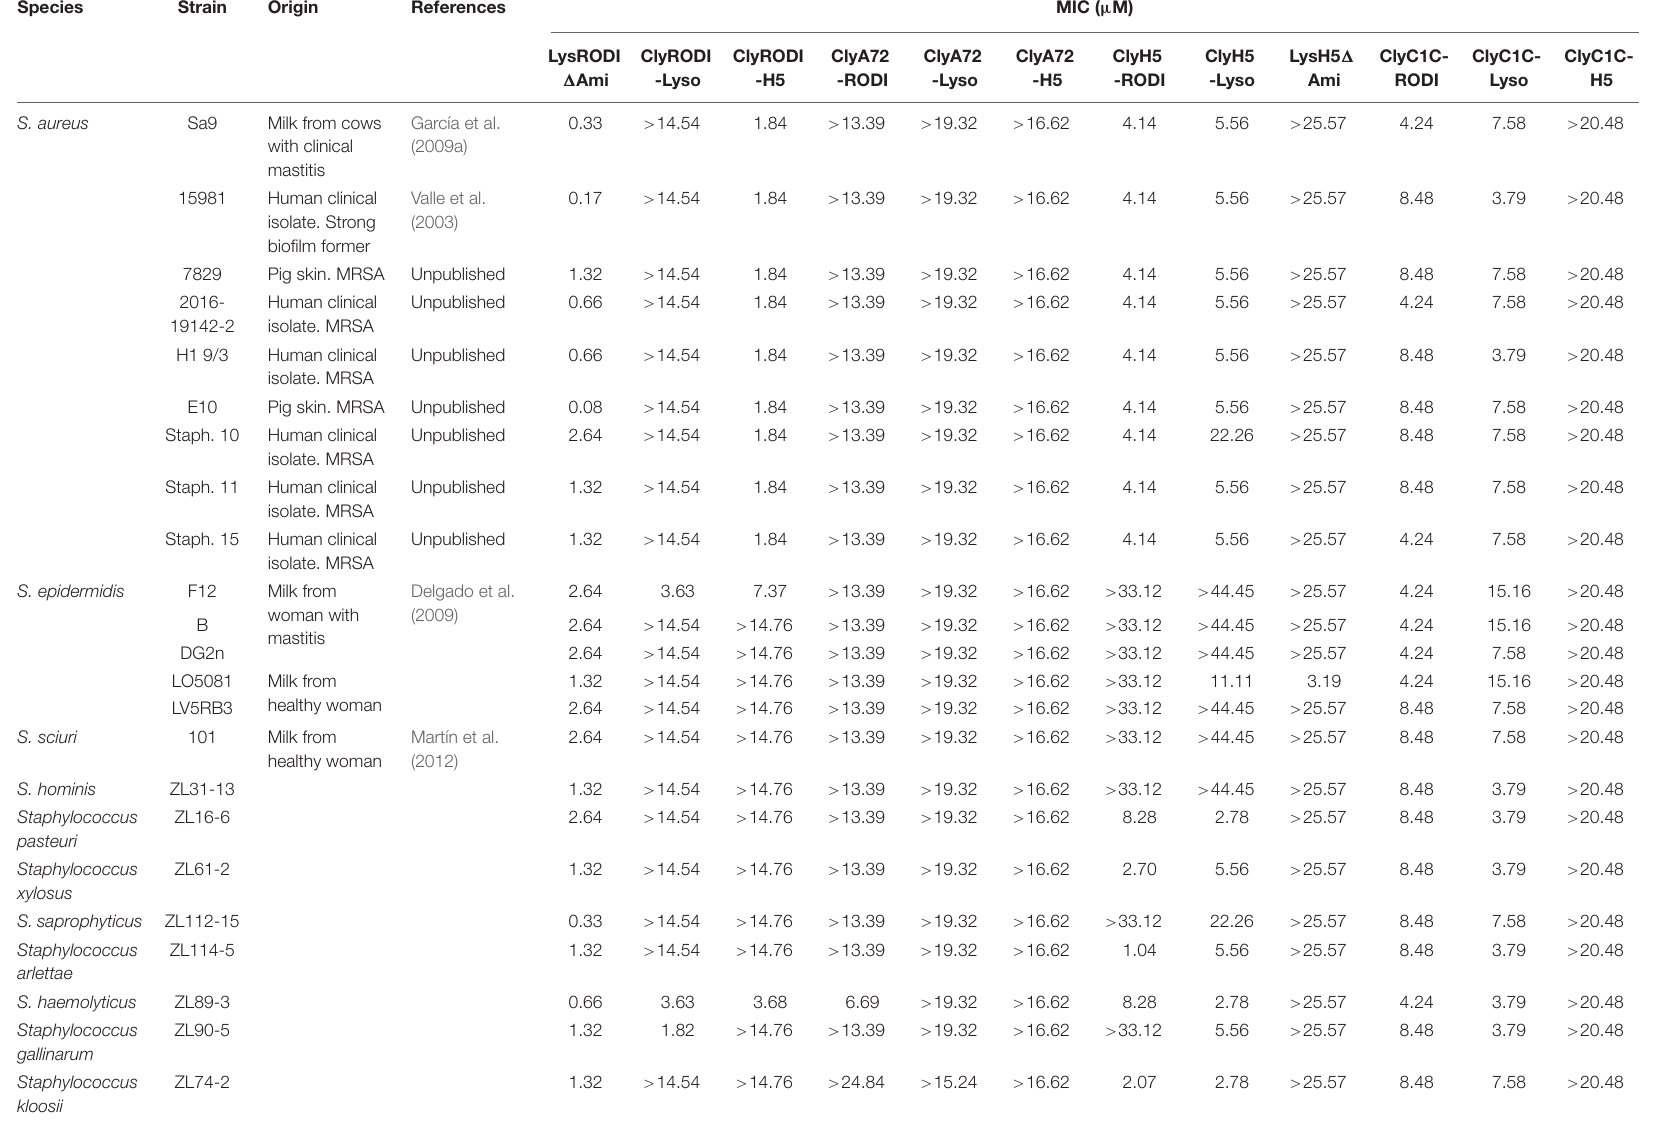
TABLE 1 | Staphylococcal collection used in this work and MIC values of the engineered proteins. Species